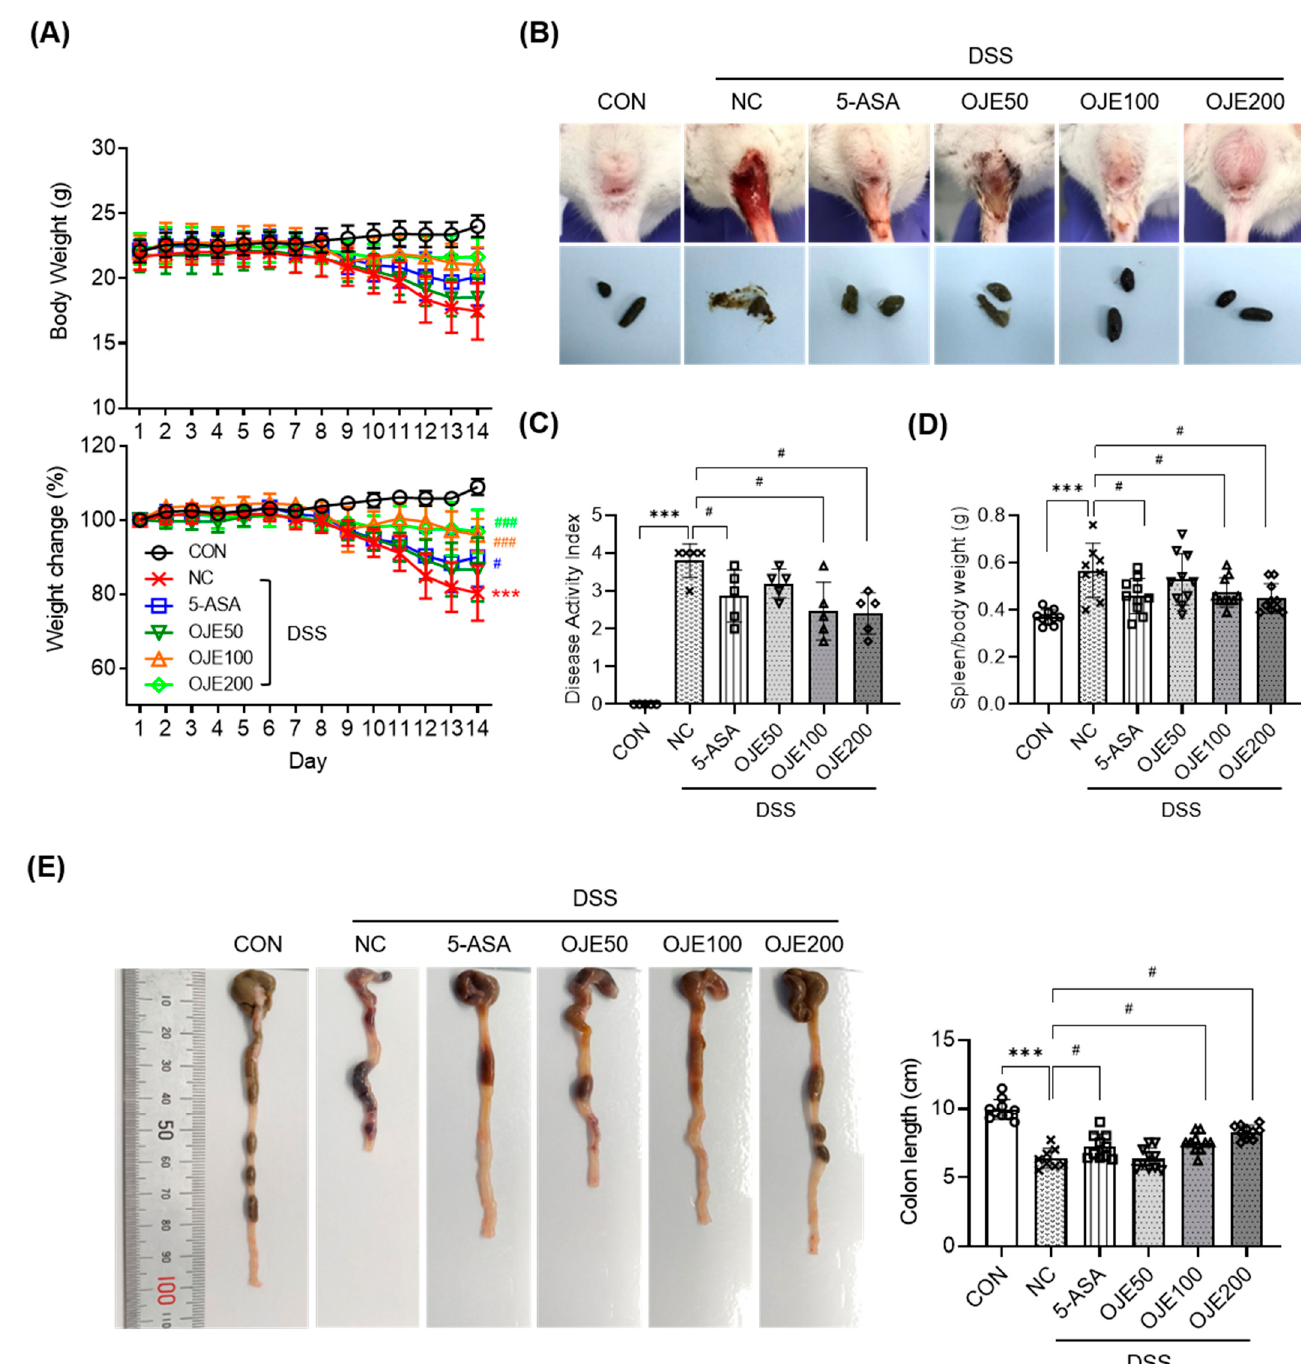
Figure 3. Effects of OJE administration on ( A ) body weight, weight change rate, ( B ) feces, anus and ( C ) DAI score ( D ) spleen/body weight and ( E ) colon length in mice with DSS–colitis. Values are the mean ± SEM ( n = 8–10). *** p < 0.001, NC vs. CON; # p < 0.05, 5–ASA 50 mg/kg, OJE 50 mg/kg, OJE 100 mg/kg, OJE 200 mg/kg vs. DSS+NC.